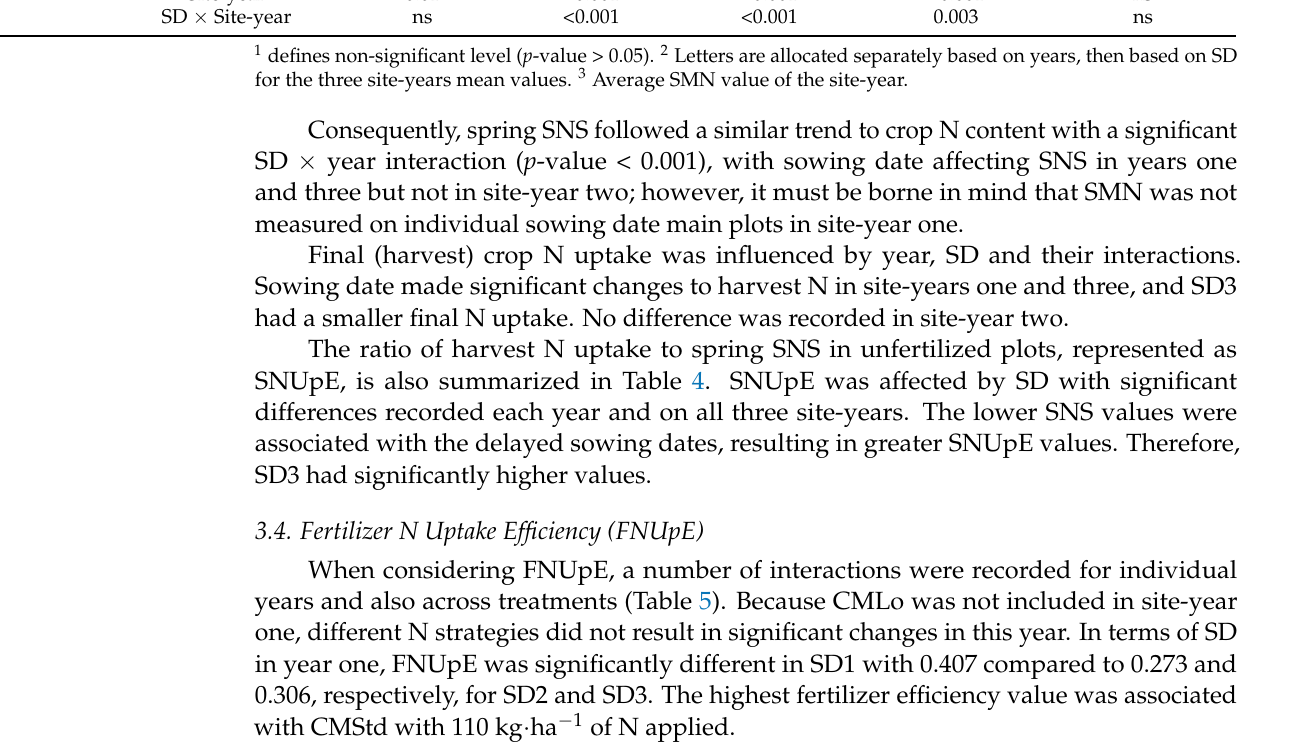
Table 5. The effect of sowing date and fertilizer application strategy on FNUpE over three